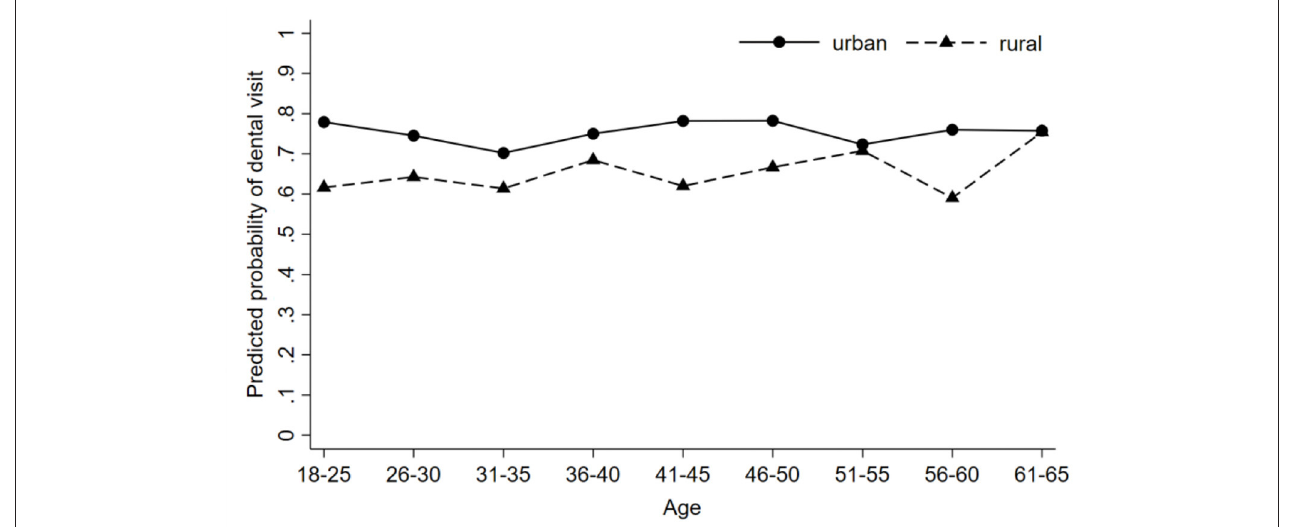
FIGURE 2 | Disparities in predicted probability of having dental visit by place of residence (urban vs. rural) with 95% confidence intervals ( N = 4,049, weighted). All estimations include gender, marital status, education, attending the regular physical exam, care about eating a healthy diet, father’s occupational status, individual’s occupational status, income, insurance, self-rated health, tooth loss, and gum bleeding as